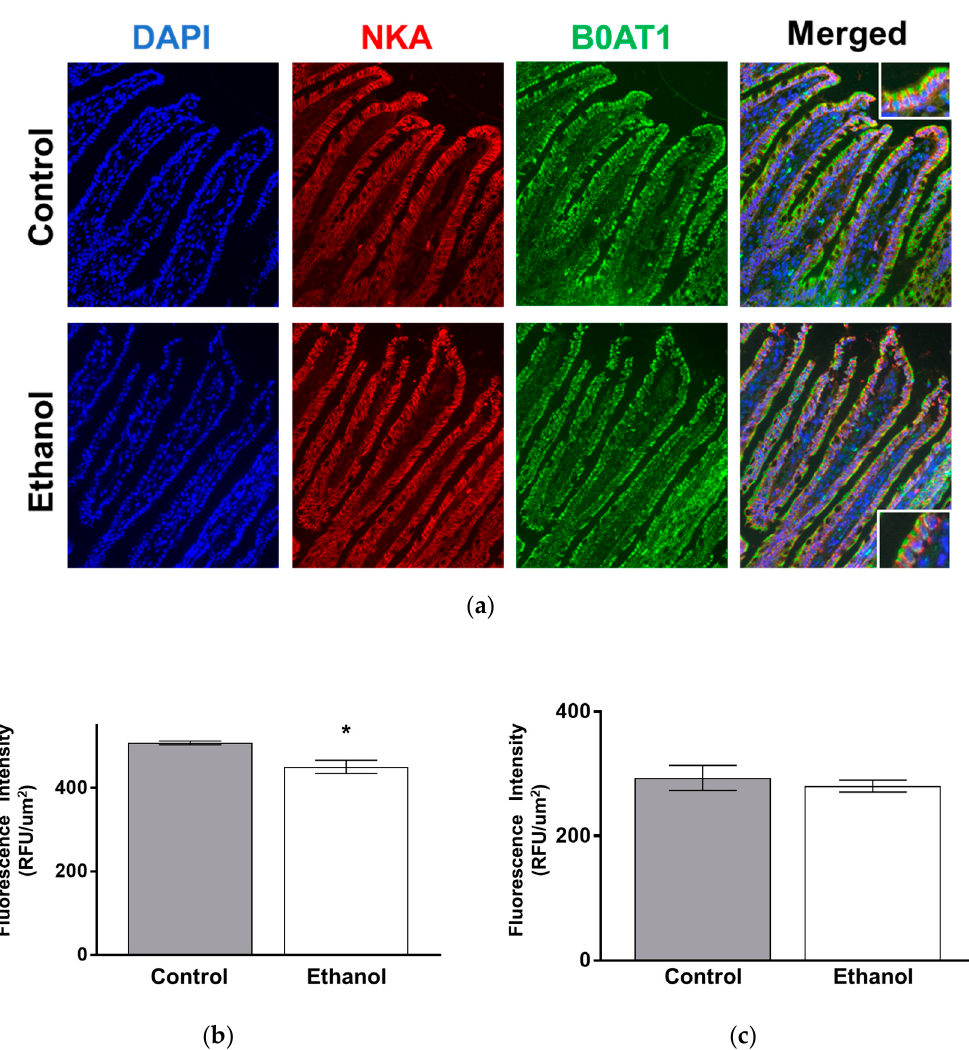
Figure 5. One hour of moderate ethanol significantly decreased the immunofluorescence intensity of B0AT1 in SD rats. ( a ) Shown are representative images taken using a 20 × objective. The green stain represents B0AT1. The red stain represents the Na-K-ATPase α -1 subunit (NKA). The blue stain represents DAPI. ( b ) Quantification of immunofluorescence intensity of B0AT1 in SD rats (* p < 0.05, n = 4). ( c ) Quantification of immunofluorescence intensity of the Na-K-ATPase α -1 subunit ( p > 0.05, n = 4). Each sample is an average of five different images obtained using a 20× objective. The error bars represent the SEM.